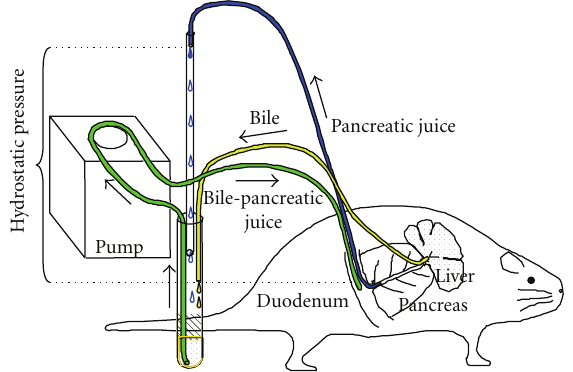
Figure 5: Schematic diagram of the experimental setup. The height from the level of the ampulla Vater to the free end of the pancreatic cannula represents the hydrostatic pressure to the